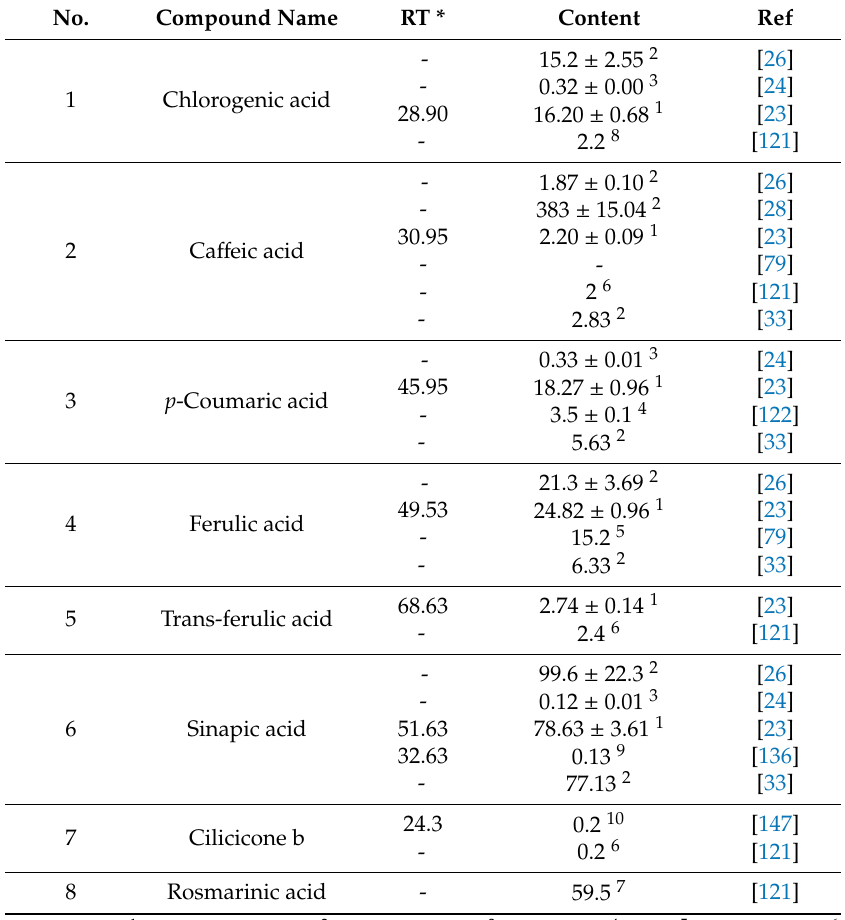
Table 4. Di ff erent identified hydroxycinnamic acids (phenylpropanoids) in green walnut husk along with their retention time and